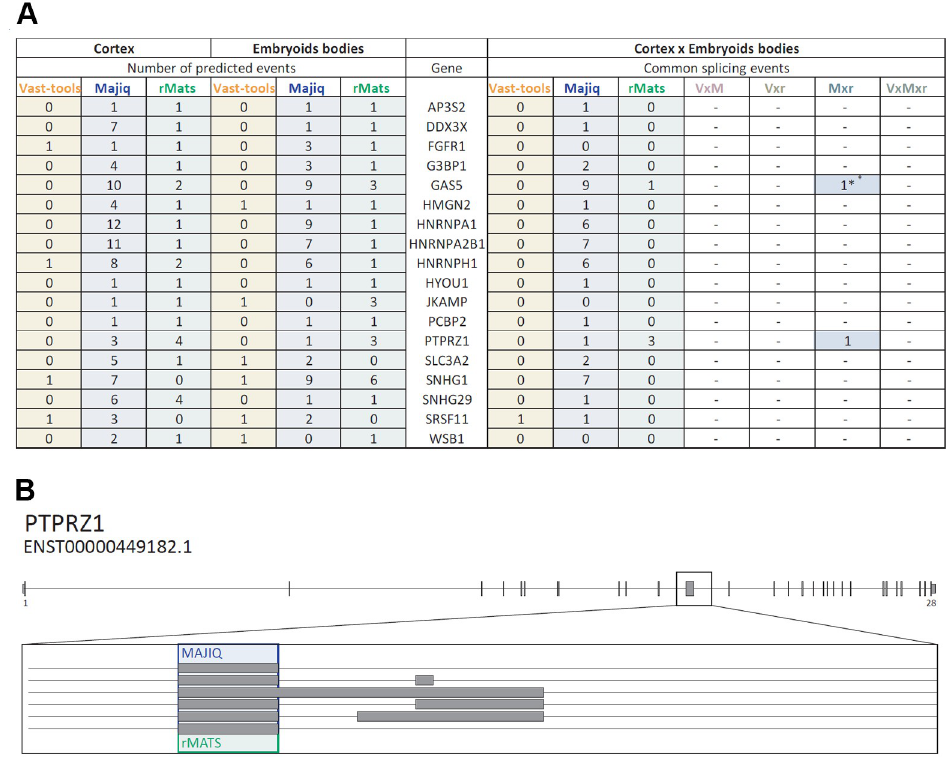
Fig 5. Common splice events predicted to be altered by ethanol in the cortex and embryoid bodies datasets. A) Common genes whose alternative splicing was predicted to be affected by ethanol in the cerebral cortex and embryoid bodies. The left side of the table details the number of splicing events predicted by each of the bioinformatics tools. The right side of the table shows the number of splicing events common for cerebral cortex and embryoid bodies predicted by each of the bioinformatics tools, and the number of splicing events common for cerebral cortex and embryoid bodies predicted by at least two of them. * Indicates that the alternative splicing events do not have the same coordinates, but they overlap. Comparison between bioinformatics predictions are coded as follows: VxM; VAST-TOOLS and MAJIQ matches, Vxr; VAST-TOOLS and rMATS matches, Mxr; MAJIQ and rMATS matches, VxMxr; Vast-tools, MAJIQ, and rMATS matches. B) Diagram of the BPTPBZ1 gene (ENST00000449182.1) illustrating the location of the splicing event predicted to be affected by ethanol in the cerebral cortex and embryoid bodies according to MAJIQ and rMATS analyses. The blue box represents the coordinates of MAJIQ predicted event and the green box represents the coordinates of rMATS predicted event. Intron sequences are represented by lines, exons by grey boxes, and UTR sequences by slim grey boxes. The diagrams show the genes in the 5´to 3´ direction. Small numbers under the first and last exons indicate the number of the corresponding exon according to GENCODE V41.